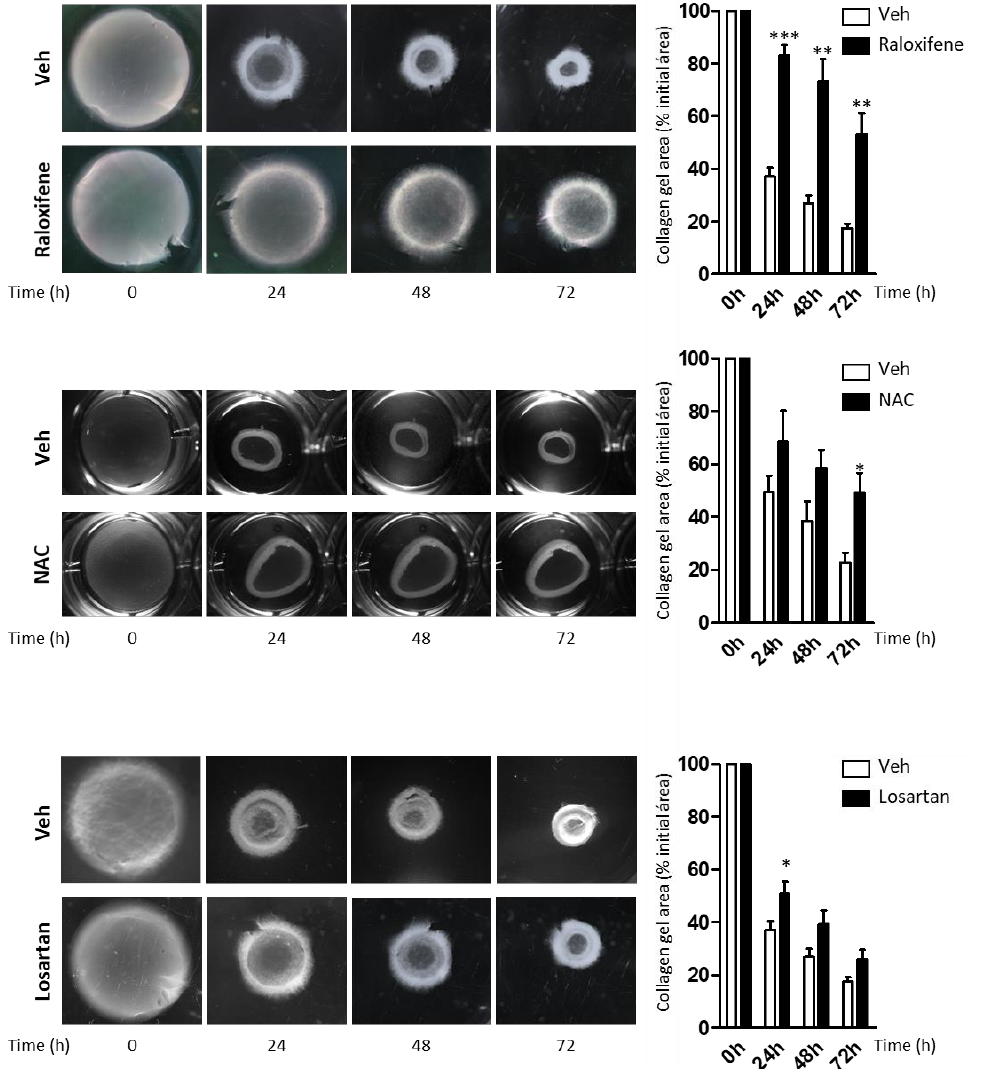
Figure 4. Effect of raloxifene an NAC on contraction in a collagen gel assay. Fibroblasts from RDEB patients were embedded in collagen gels in the presence of raloxifene (5 μM), NAC (1 mM), losartan (10 µM) or the vehicle alone (Veh), and the gel area was measured at the times indicated. Left, representative stereomicroscope images of the collagen gels. Right graphs show the contraction of collagen gels at the times indicated in reference to the surface area at time 0, represented as the mean contraction relative to Veh of three independent experiments (mean ± SEM): * p < 0.05; ** p < 0.01; *** p < 0.005 .